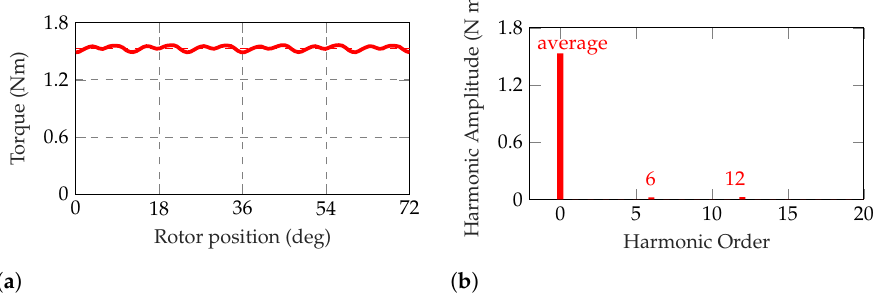
Figure 21. Torque waveform and harmonic content of the 12/10 spoke PM motor. ( a ) Torque waveform. ( b ) Harmonic content.